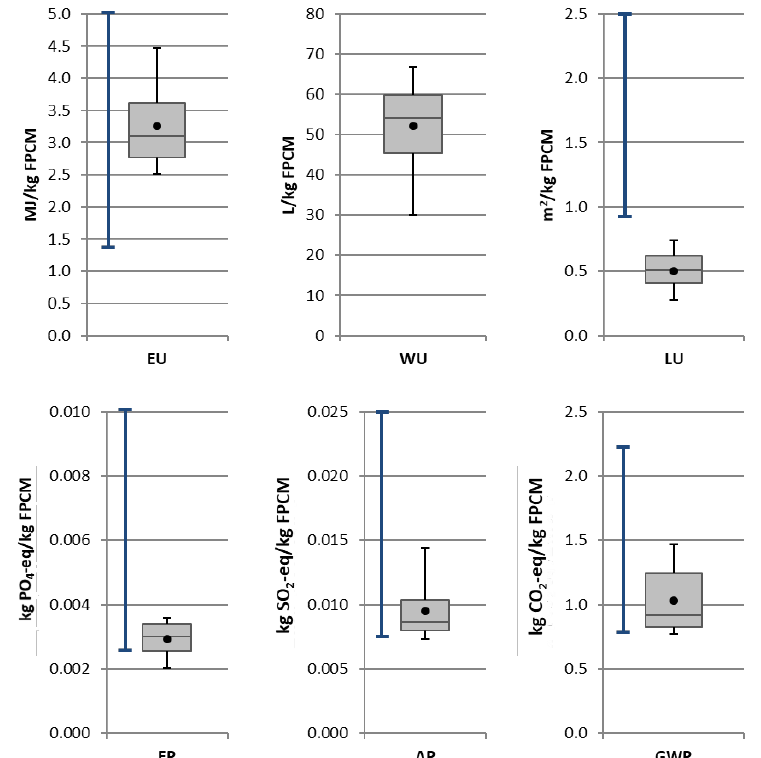
Figure 3. Results for the selected environmental impacts throughout the LCA of 1 kg FPCM: systems in Israel versus global results.